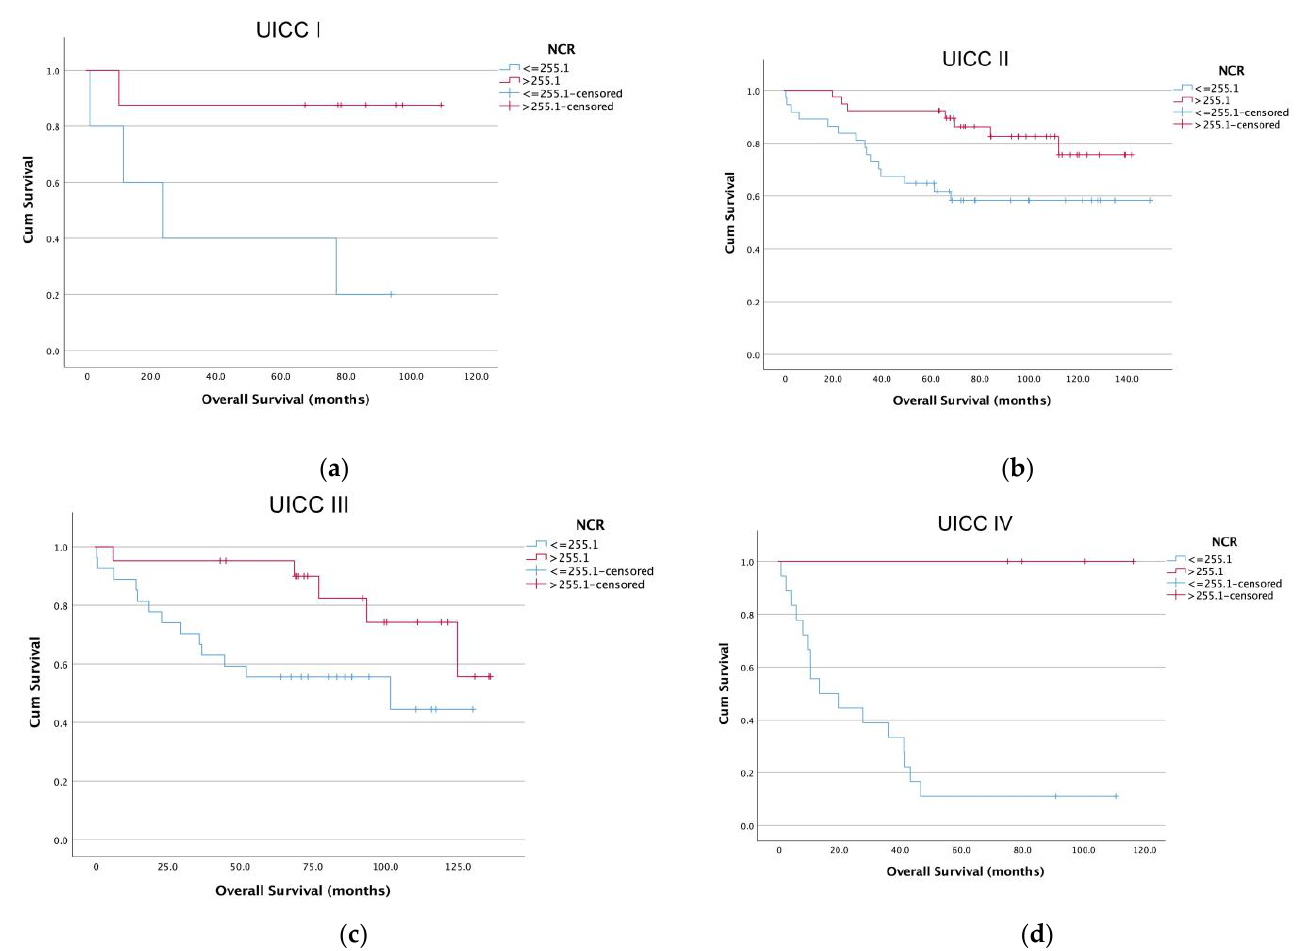
Figure 4. Prognostic effect of the NCR status on the OS of patients with colon cancer stratified according to UICC classification ( a ) Kaplan–Meier curves for OS based on UICC stage 1; ( b ) UICC stage II ( c ) UICC stage III and ( d ) UICC stage IV patients in the discovery cohort.